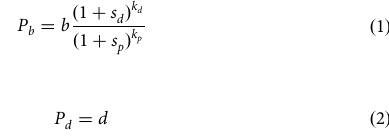
Fig. 4 Three-dimensional model of tumor evolution constrained by ductal network structure. a Realistic three-dimensional topology of breast ductal networks (reconstructed with data from anthropomorphic breast phantoms in 48 ) provides full three-dimensional maps to seed and constrain tumor evolution simulations. b Tumor evolution is shown for varied points of initiation (z-dimension shown in a ), to identical sizes ( N = 10 4 cells). See attached videos V4 and V5. Two parameterizations are shown: DC13 (solid lines; μ p = 10 − 2 ; μ d = 10 − 3.0 ; s d = 10 − 1 ; s p = 10 − 3 ; indicated as red circle ( a ) in Fig. 3g) and DC16 (solid lines; μ p = 10 − 2 ; μ d = 10 − 2.5 ; s d = 10 − 2 ; s p = 10 − 3 ; indicated as green circle ( b ) in Fig. 3l). The slope of trajectories (schematic) on this phase portrait is termed “ realized tumor Darwinian fi tness ” and is dependent on spatial constraints at the point of tumor initiation. Simulations closer to the ductal root (e.g., blue curve, z = 25%) in larger, less constrained branches are characterized by a steady left-to-right (neutral) evolution and constant acquisition of new clones. Simulations further from the ductal root (e.g., green, z = 75%) in smaller, more constrained branches are characterized by clonal sweeping (bottom-to-top evolution) early, but with a shift toward neutrality (left-to-right) at later times. Trajectories may be compared to alternative models with identical parameterizations: non-spatial model (dashed yellow), unconstrained two-dimensional model (dashed orange), or unconstrained three-dimensional model (dashed purple). c The analysis is repeated subject to spatial constraints on ten highly distinct anthropomorphic breast phantom ductal network reconstructions. In general, ductal branches far from the root decrease in size and increase in number (see Supplementary Fig. 5). d All simulations tend to follow an initially Darwinian evolutionary trajectory (steep slope) followed by a transition to neutral evolution (shallow slope). e , f An alternative metric of tumor neutrality: the linearity of cumulative mutation distribution with respect to inverse allelic frequency, sometimes called the 1/f power-law distribution 5 . Although all tumors initially are quantitatively shown to be non-neutral, all eventually progress to neutral or nearly-neutral state (the neutral minimum threshold of 0.98 5 shown in black). Tumors with initially high spatial constraints (green violin plots) transition to neutral evolution more slowly than those with less spatial constraints (blue violin plots). High spatial constraints enable accelerated evolution over a range of ductal networks in ( c ) (see Supplementary Fig. 4). Violin plots show median (diamond), 25/75 percentiles, and smallest/largest values within 1.5 times the interquartile range above/below quartiles) for N = 10 simulations for each